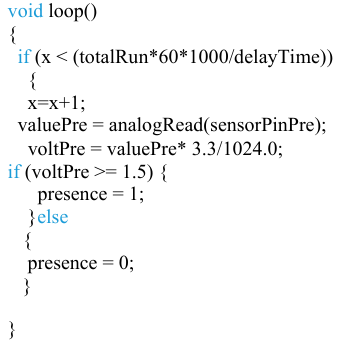
Figure 20. Code for presence sensor.